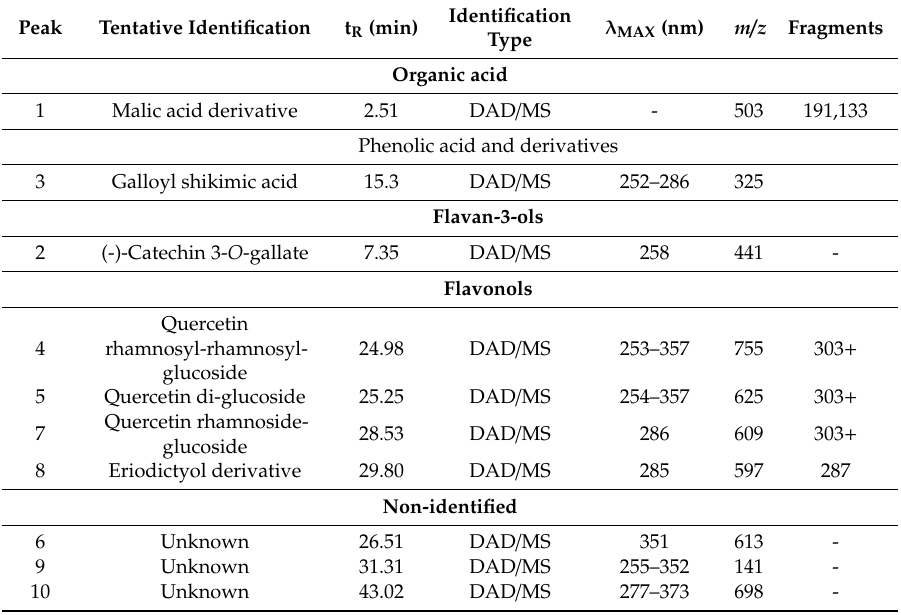
Table 6. Polyphenolic compounds detected in Z. lotus (MeOH-H 2 O extract) by HPLC-DAD-ESI / MS. Peak